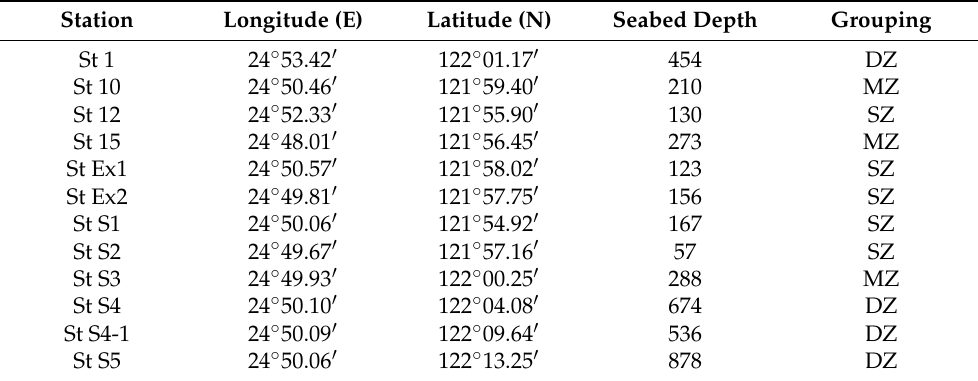
Table 1. Location and depth of sampling stations in waters off northeastern Taiwan, SZ = shallow depth zone (<200 m), MZ = middle depth zone (200–400 m), DZ = deep depth zone (>400